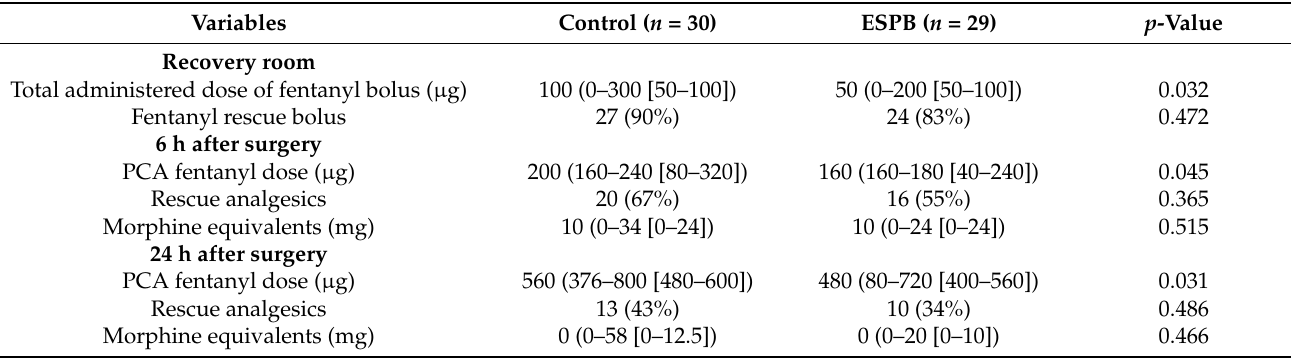
Table 2. Total administered dose of fentanyl bolus or cumulative administered fentanyl dose of PCA, and number of patients who required rescue analgesics in the recovery room, and at 6 h and 24 h after surgery.